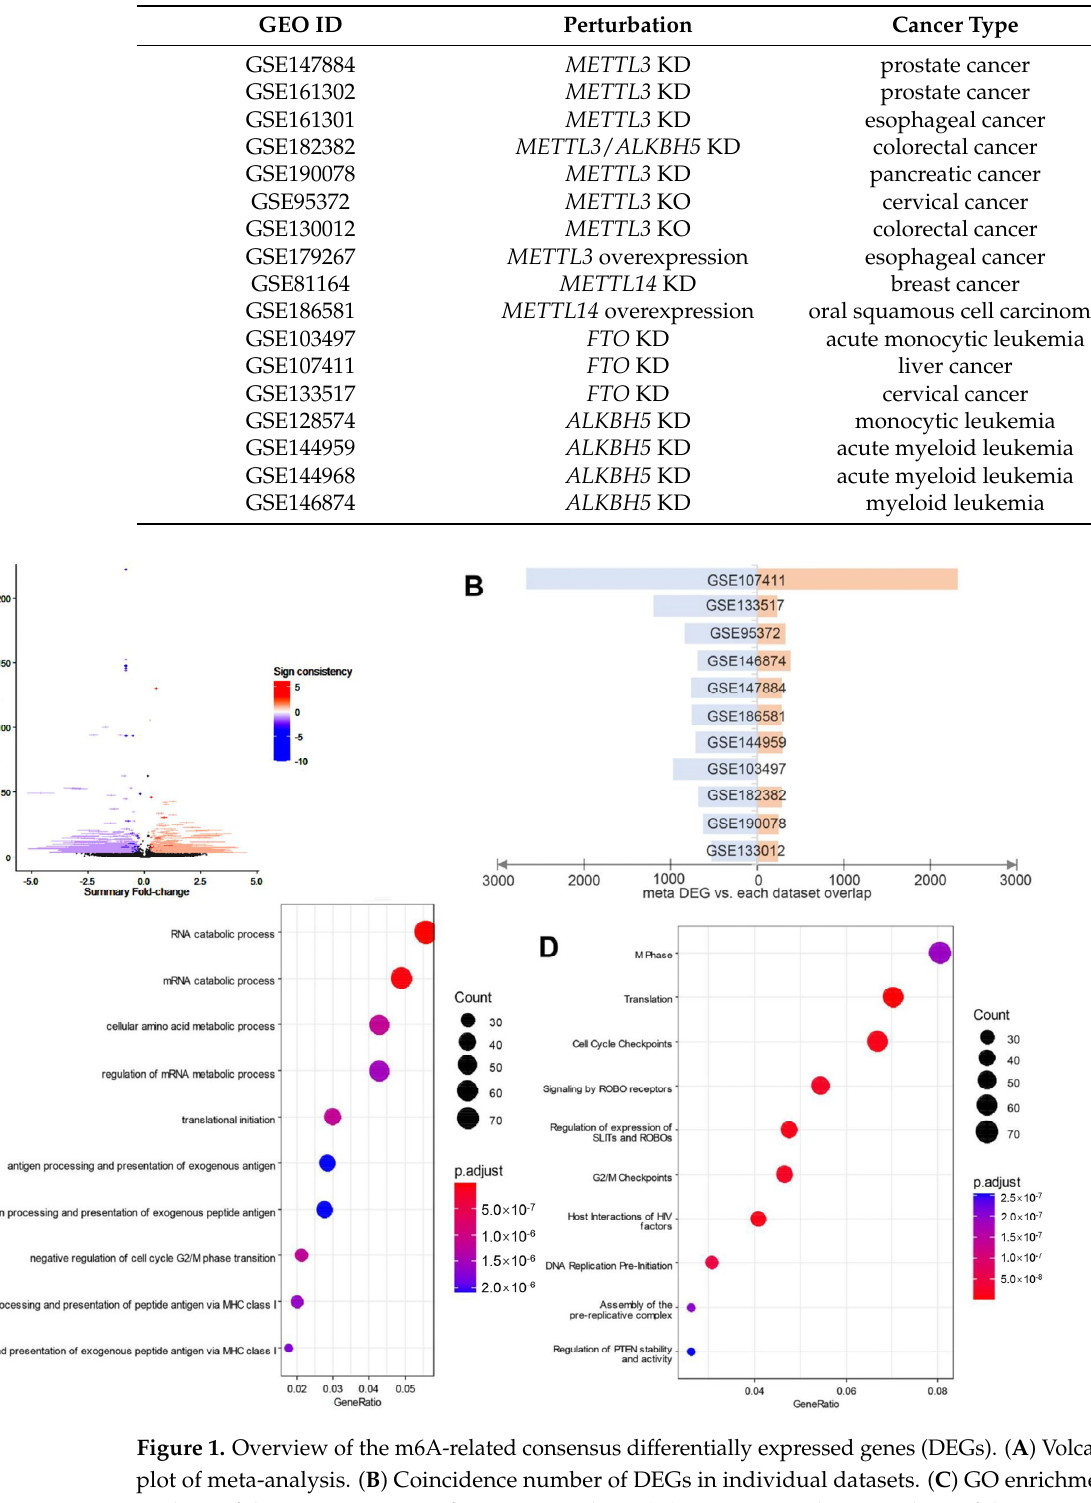
Table 1. Transcriptome datasets with m6A perturbation covered in this study.